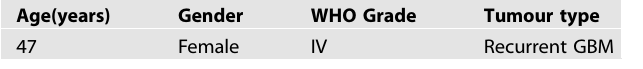
Table l. Patient data of the tumours.